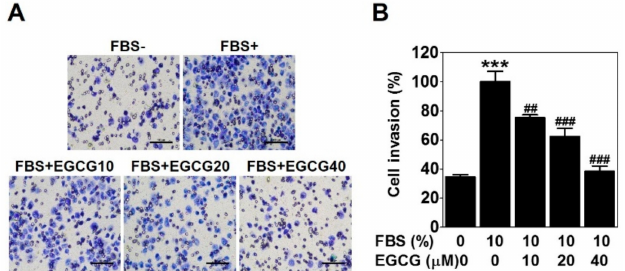
Figure 2. EGCG reduces the invasion of PC-3 cells. The cell invasion assay was performed using a Transwell with a matrigel-coated membrane filter for 24 h. Cells were stained, and noninvaded cells on the upper surface of the filter were removed. ( A ) Images were photographed at 200 × magnification. Scale bar = 100 µ m. ( B ) The number of cells invading the lower surface of the filter was quantified. Data are expressed as means ± SD. Results were statistically calculated by Student’s t -test. *** p < 0.001 vs. untreated control; ## p < 0.01 and ### p < 0.001 vs. fetal bovine serum (FBS)-treated